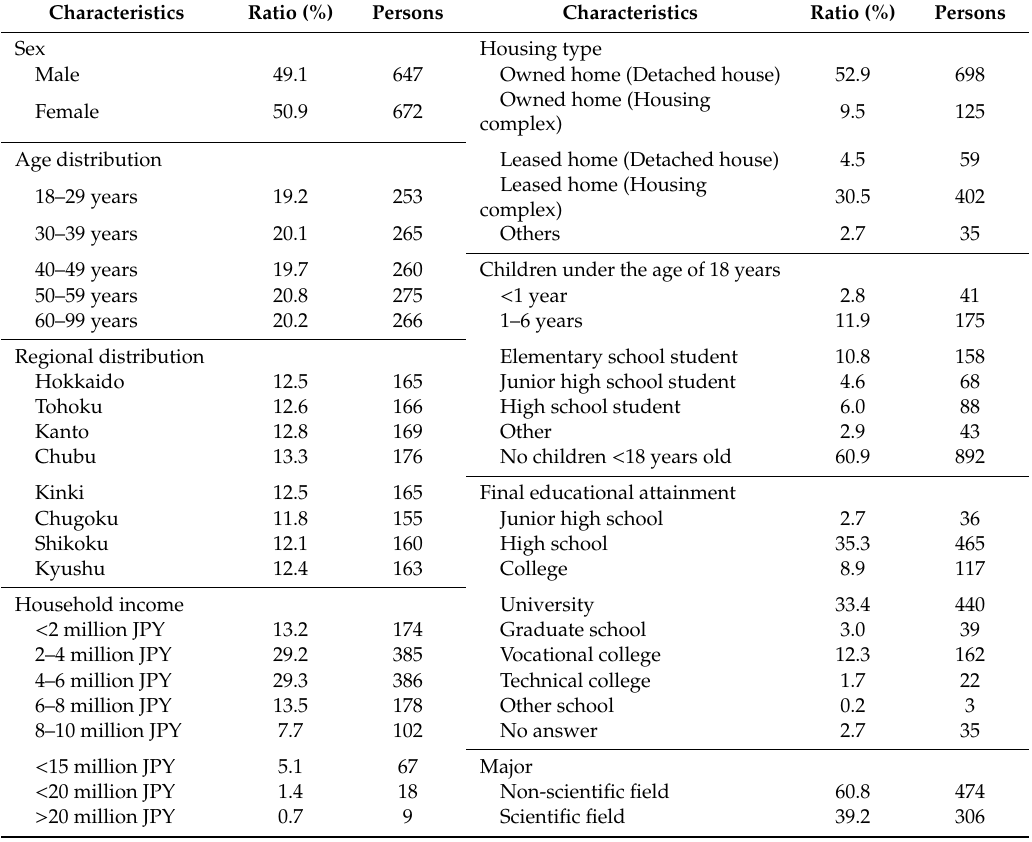
Table 1. Subject attributes ( N =